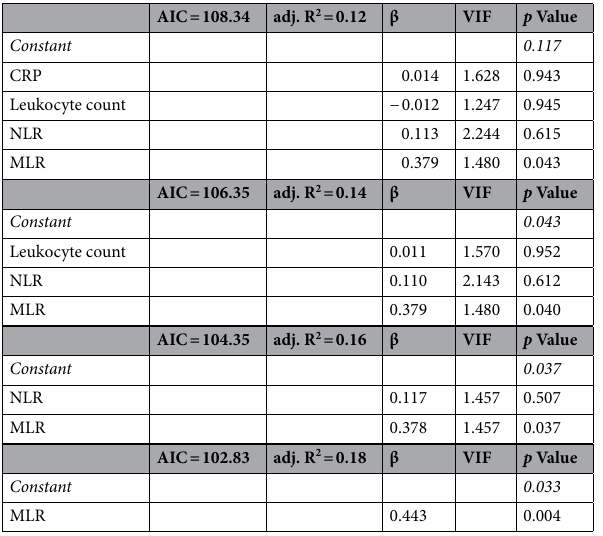
Table 4. Multivariate linear regression analysis for the prediction of length of hospital stay using the stepwise method with backward direction. Abbreviations: CRP = C-reactive protein, NLR = neutrophil-to-lymphocyte ratio, MLR = monocyte-to-lymphocyte ratio, AIC = Akaike information criterion, adj. = adjusted, VIF = variance inflation